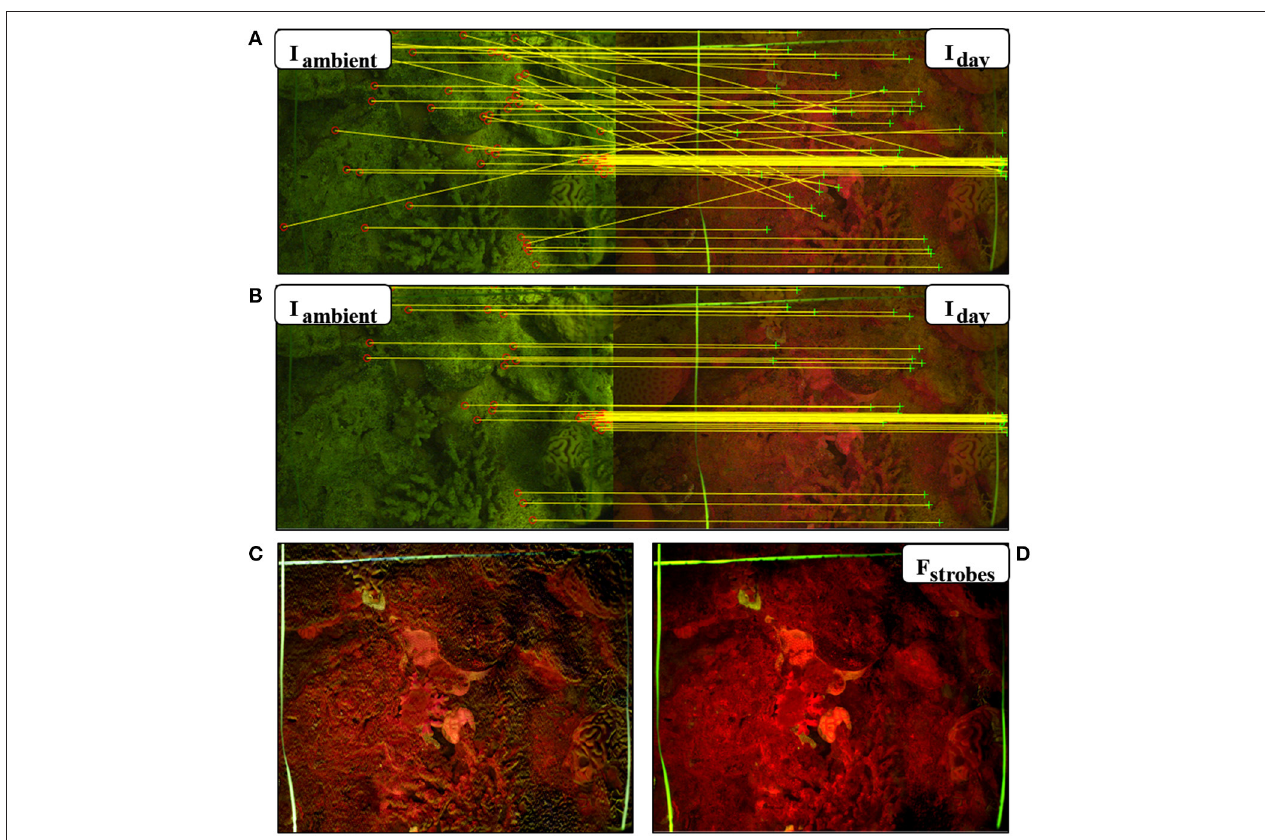
FIGURE 2 | Automatic ambient light subtraction. (A,B) Fluorescence image pairs taken during the day using the FluorIS, with the blue strobes off (I ambient ) and blue strobes on